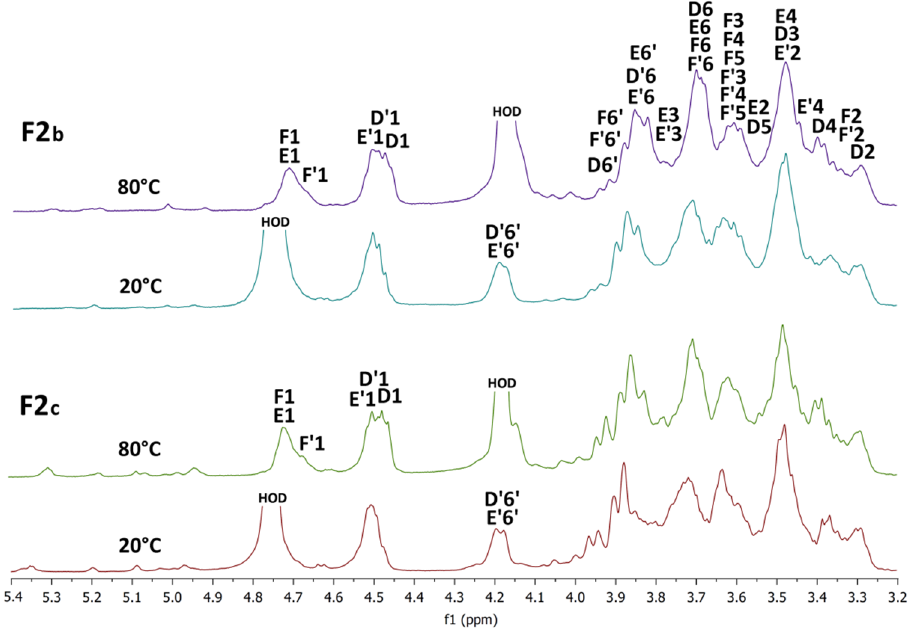
Figure 8. 1 H NMR spectra of the sub ‐ fractions F2b and F2c measured in D 2 O at 20 °C and 80 °C.